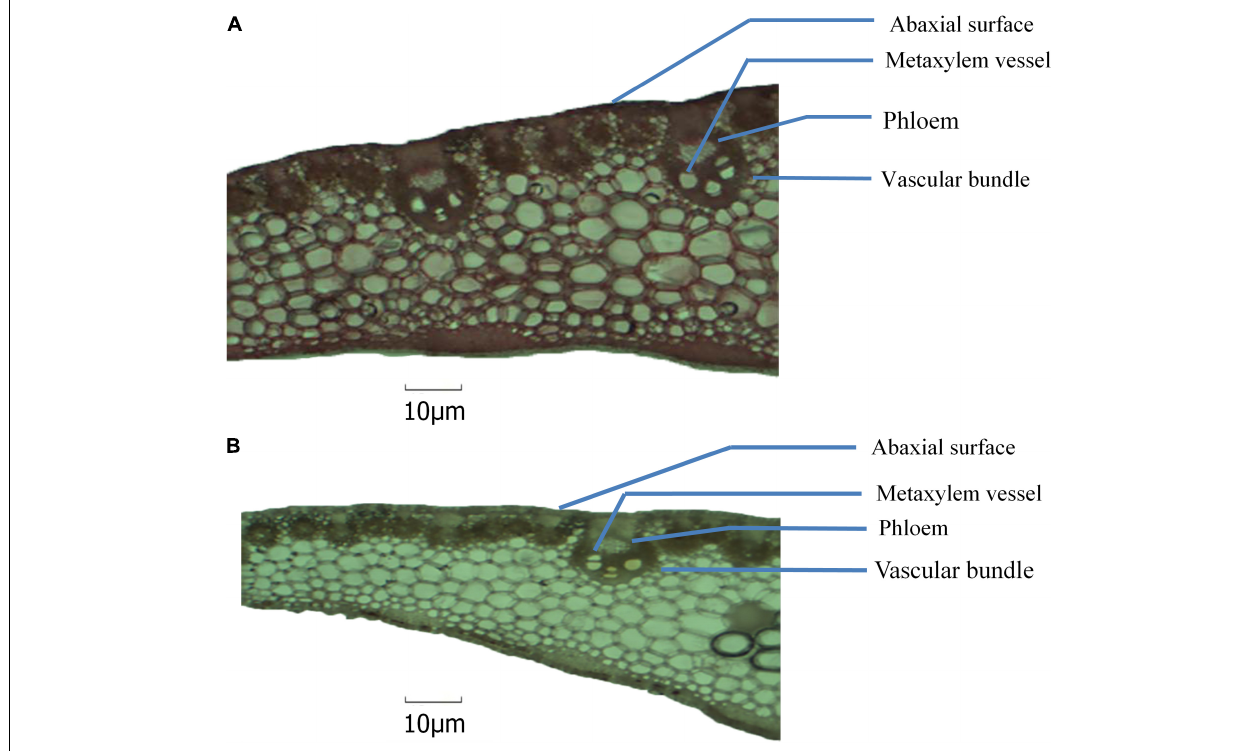
FIGURE 12 | Anatomical view of leaf blade attached with mid-rib of NK 40 under control (A) and water deficit (B) after milking